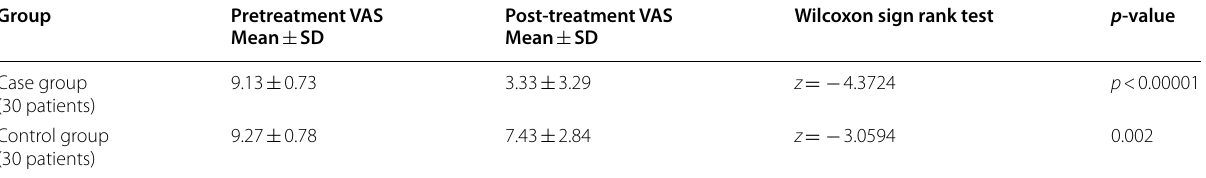
VAS visual analog scale